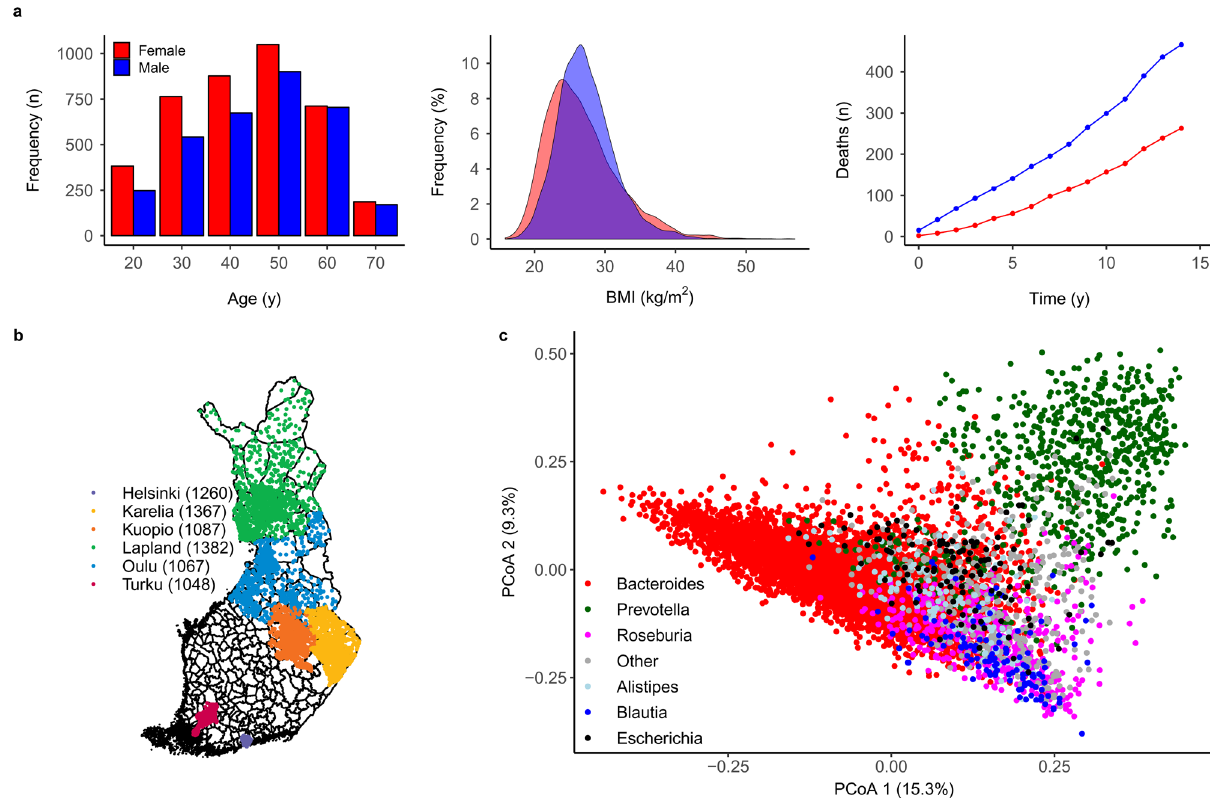
Fig. 1 Study sample and gut microbiome characteristics. a At baseline, the study sample ( n = 7211) had a balanced sex ratio (55% women in red:men in blue), a mean age of 49 years (range 24 – 74; left panel) and a mean body mass index (BMI) of 27 kg/m 2 (range 16 – 57; middle panel). During a median follow-up time of 14.8 years, 721 of 7055 (10.2%) participants with complete data who were included in the prospective analysis died (right panel). b A total of 7211 out of 13,500 randomly sampled individuals (53.4% participation rate) from six catchment areas in Finland underwent stool sampling, a physical examination and fi lled in a questionnaire on health behaviour, history of diseases and current health. c Principal coordinate analysis (PCoA) indicates sample similarity based on species-level taxonomic composition. The colour indicates the dominant (most abundant) genus in each sample. Altogether, 96% of the samples are dominated by one of the six genera that are indicated in the fi gure.